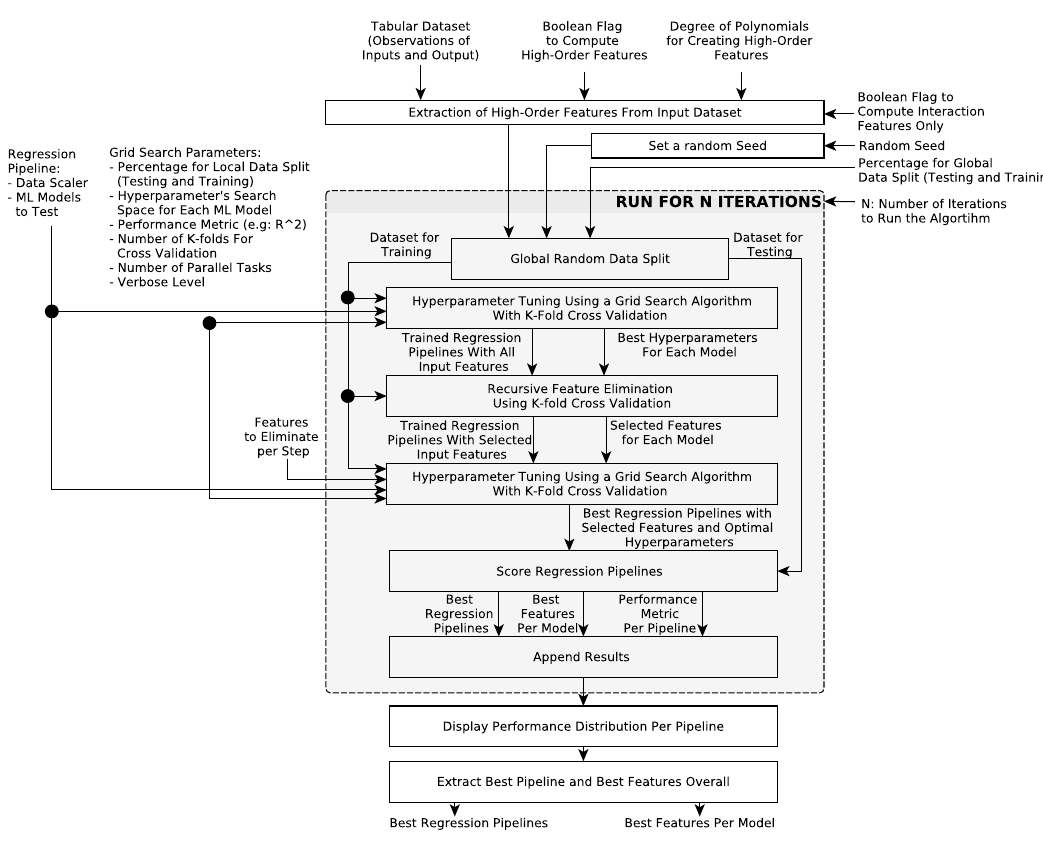
Figure 10. Autotuning